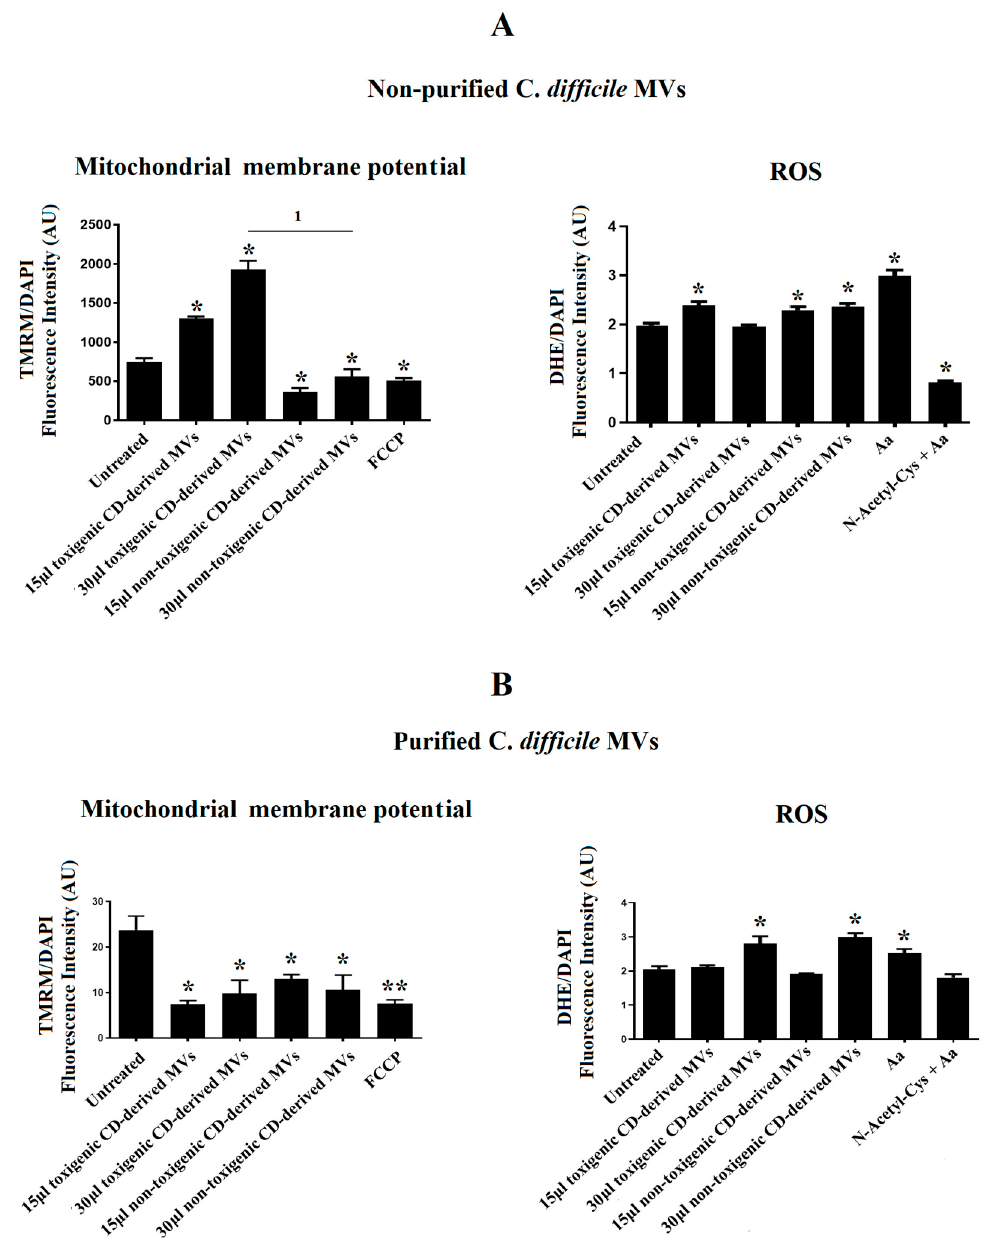
Figure 6. Effects of C. difficile- derived MVs (30 μ g total protein/mL) on the mitochondrial membrane potential (MMP) and intracellular ROS levels in HepG2. TMRM staining was used to determine the MMP in HepG2 cells. DHE staining was used to assess intracellular ROS level in live cells. ( A ) Effects of non-purified C. difficile -derived MVs. ( B ) Effects of purified C. difficile- derived MVs. * p < 0.05 and ** p < 0.001 as compared with untreated cells ( n = 6). 1 p < 0.05. FCCP: Carbonyl cyanide p -(tri-fluromethoxy) phenyl-hydrazone. aa: Antimycin A.